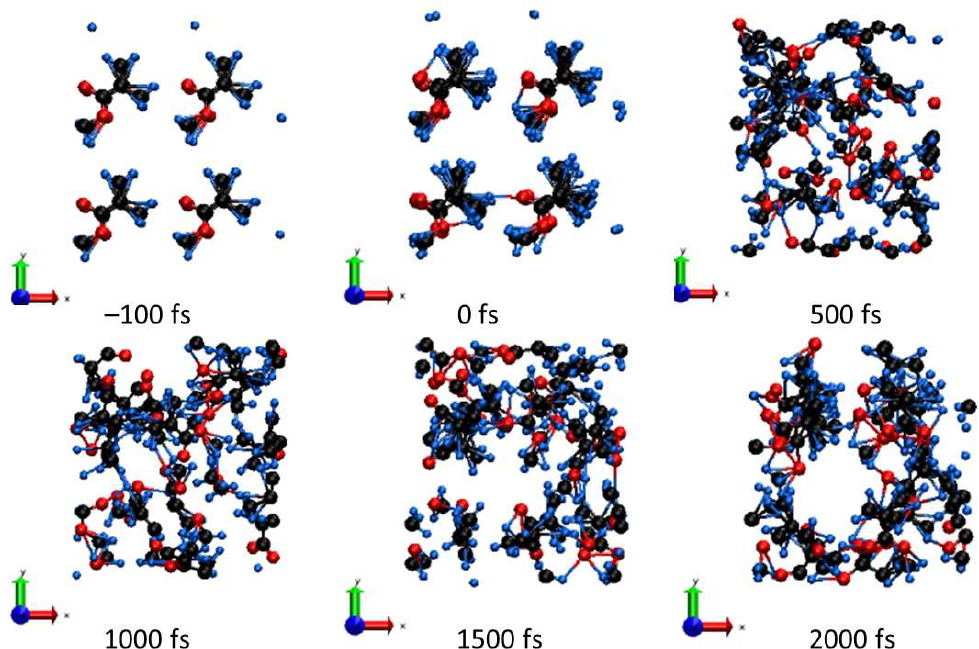
Figure 3. Atomic snapshots of the PMMA supercell irradiated with 0.1 eV/atom at different time instants.